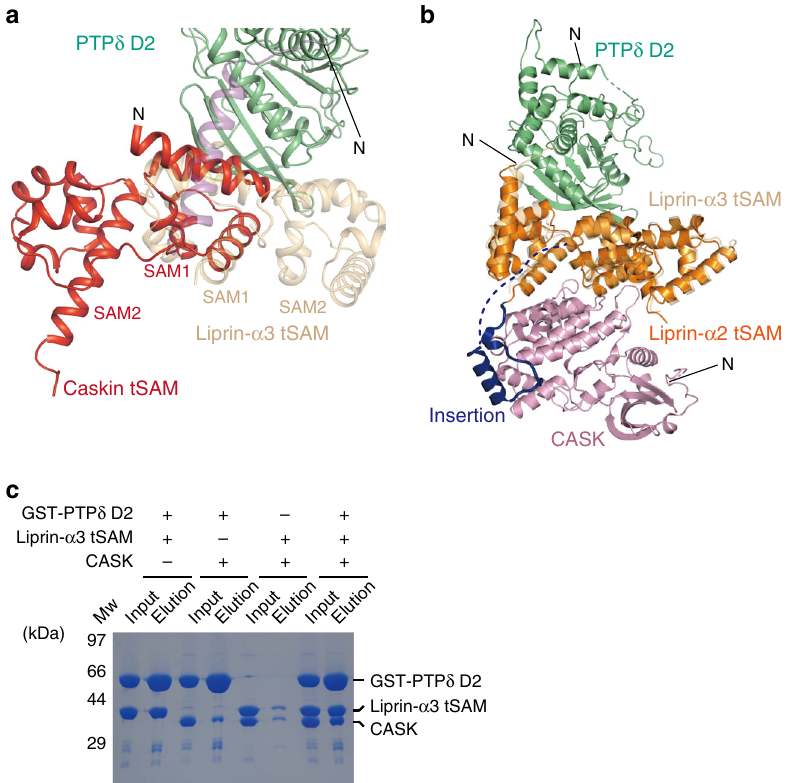
Fig. 5 Structure-based assessment of the involvement of Caskin and CASK. a Superposition of Caskin SAM1-SAM2 (red) on Liprin- α 3 tSAM ( α N, purple; SAM1-SAM2, light brown) bound to PTP δ D2 (green). b Superposition of the CASK (pink) – Liprin- α 2 tSAM (CASK-interacting loop, dark blue; other regions, orange) complex on the PTP δ D2 (green) – Liprin- α 3 tSAM (light brown) complex. No steric hindrance in this superposition suggests the formation of the tripartite signaling complex of PTP δ , Liprin- α , and CASK. c GST-pulldown assay for analyzing the formation of the tripartite complex suggested in b . Proteins bound to GST-PTP δ D2 were subjected to SDS-PAGE and stained by Coomassie Brilliant Blue. Source data are provided as a Source Data fi